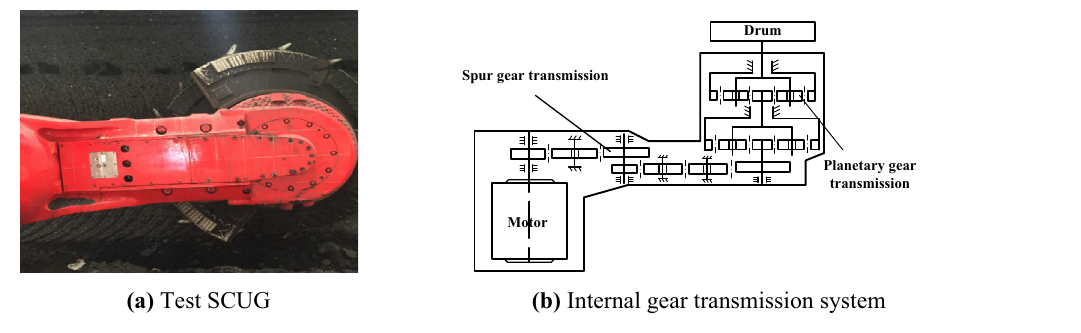
Fig. 3 View of test SCUG and internal gear transmission system